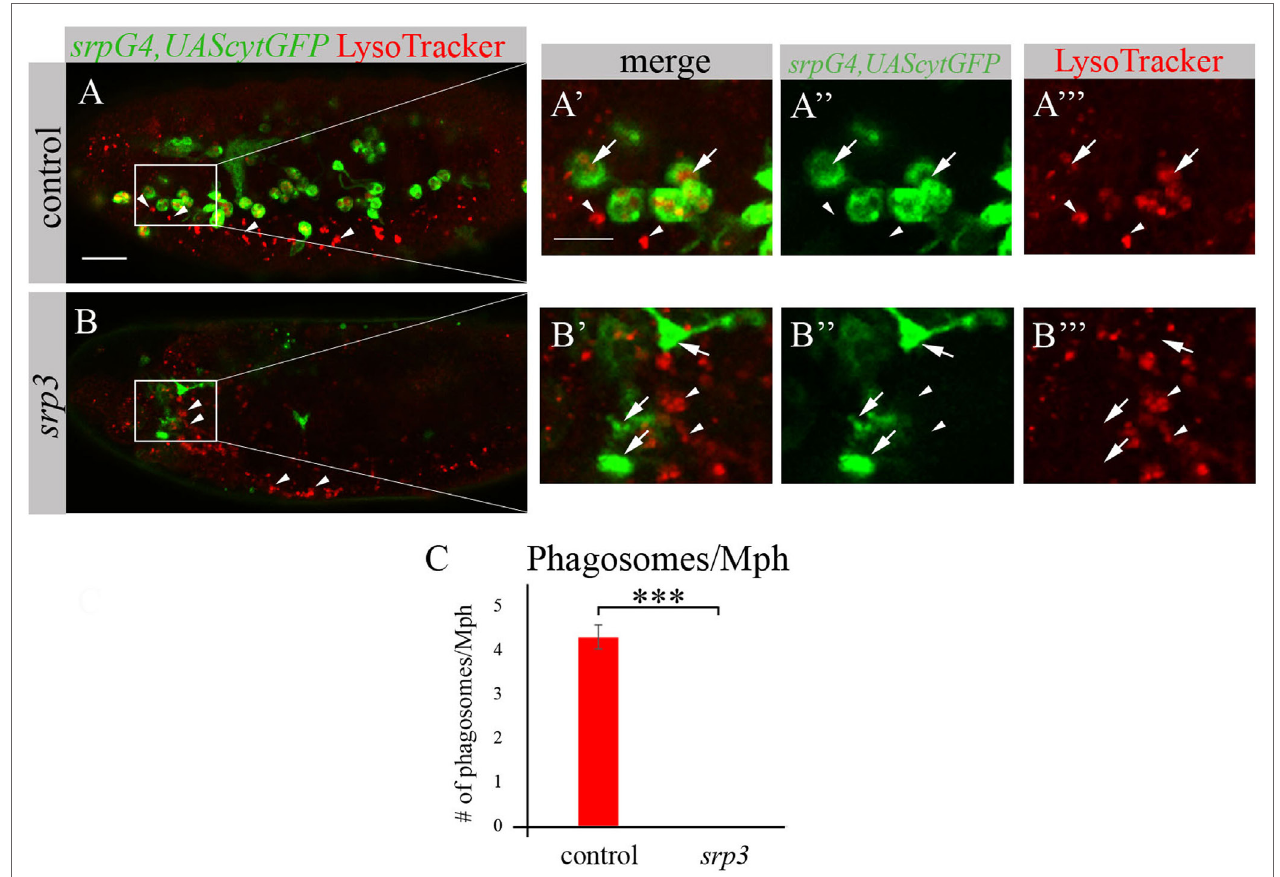
FigUre 4 | srp mutant macrophages are impaired in phagocytosis. (a–B’’’) Projections from confocal stacks of the stage 16 live embryos, lateral view. srpGal4,UAScytGFP marks macrophages in green. Phagolysosomes are labeled with LysoTracker (LT, red). (a–a’’’) Control srpGal4,UAScytGFP embryo shows numerous LT labeled phagolysosomes inside GFP-positive cells (arrows). (B–B’’’) In srp 3 mutant embryo there is no LT labeling in GFP-positive cells (arrows). LT labels glial phagolysosomes in the CNS on the ventral side (arrowheads). Bar, 20 µm. (c) Quantitation of LT-labeled phagolysosomes in macrophages of described genotypes. Columns represent mean number of phagosolysosomes per macrophage ± SEM. Control embryos ( n = 5). srp 3 mutant embryos ( n = 5). Asterisks indicate statistical significance versus control, as determined by Student’s t -test, *** p <